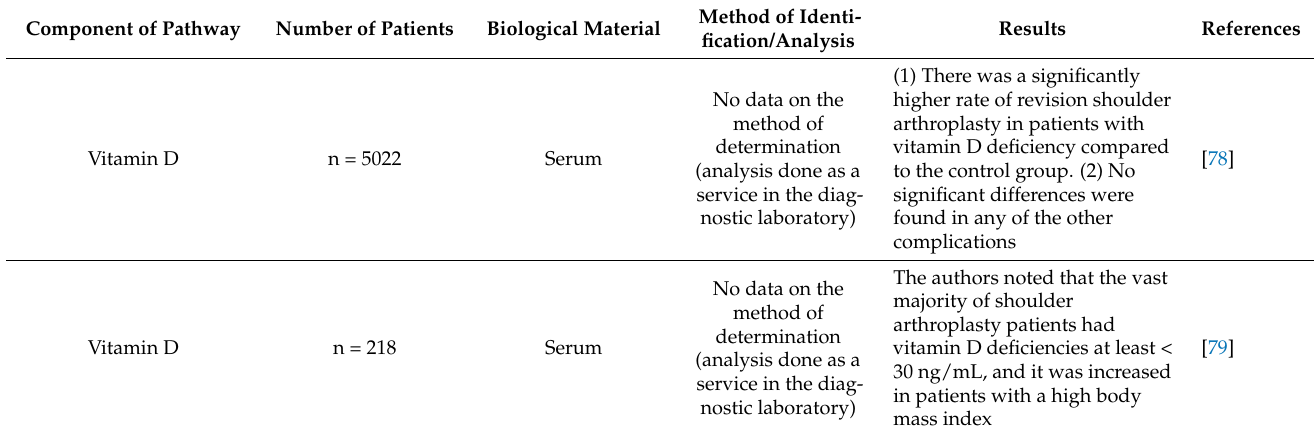
Table 5. Characteristics of the vitamin D metabolic pathway components in shoulder